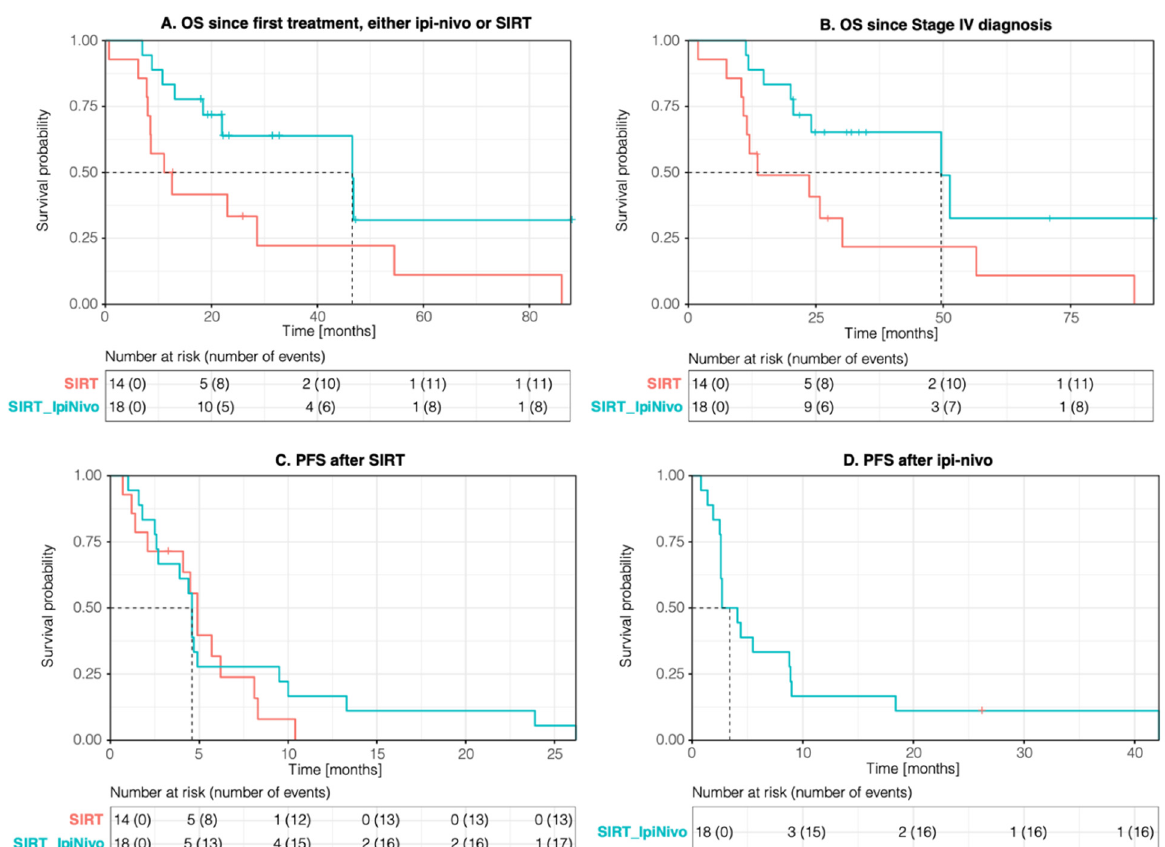
Figure 1. Kaplan–Meier curves for overall survival (OS) since first treatment ( A ) and from the diagnosis of metastases ( B ). Kaplan–Meier curve for progression-free survival (PFS) from SIRT ( C ) and from ipilimumab plus nivolumab (ipi-nivo) ( D ).